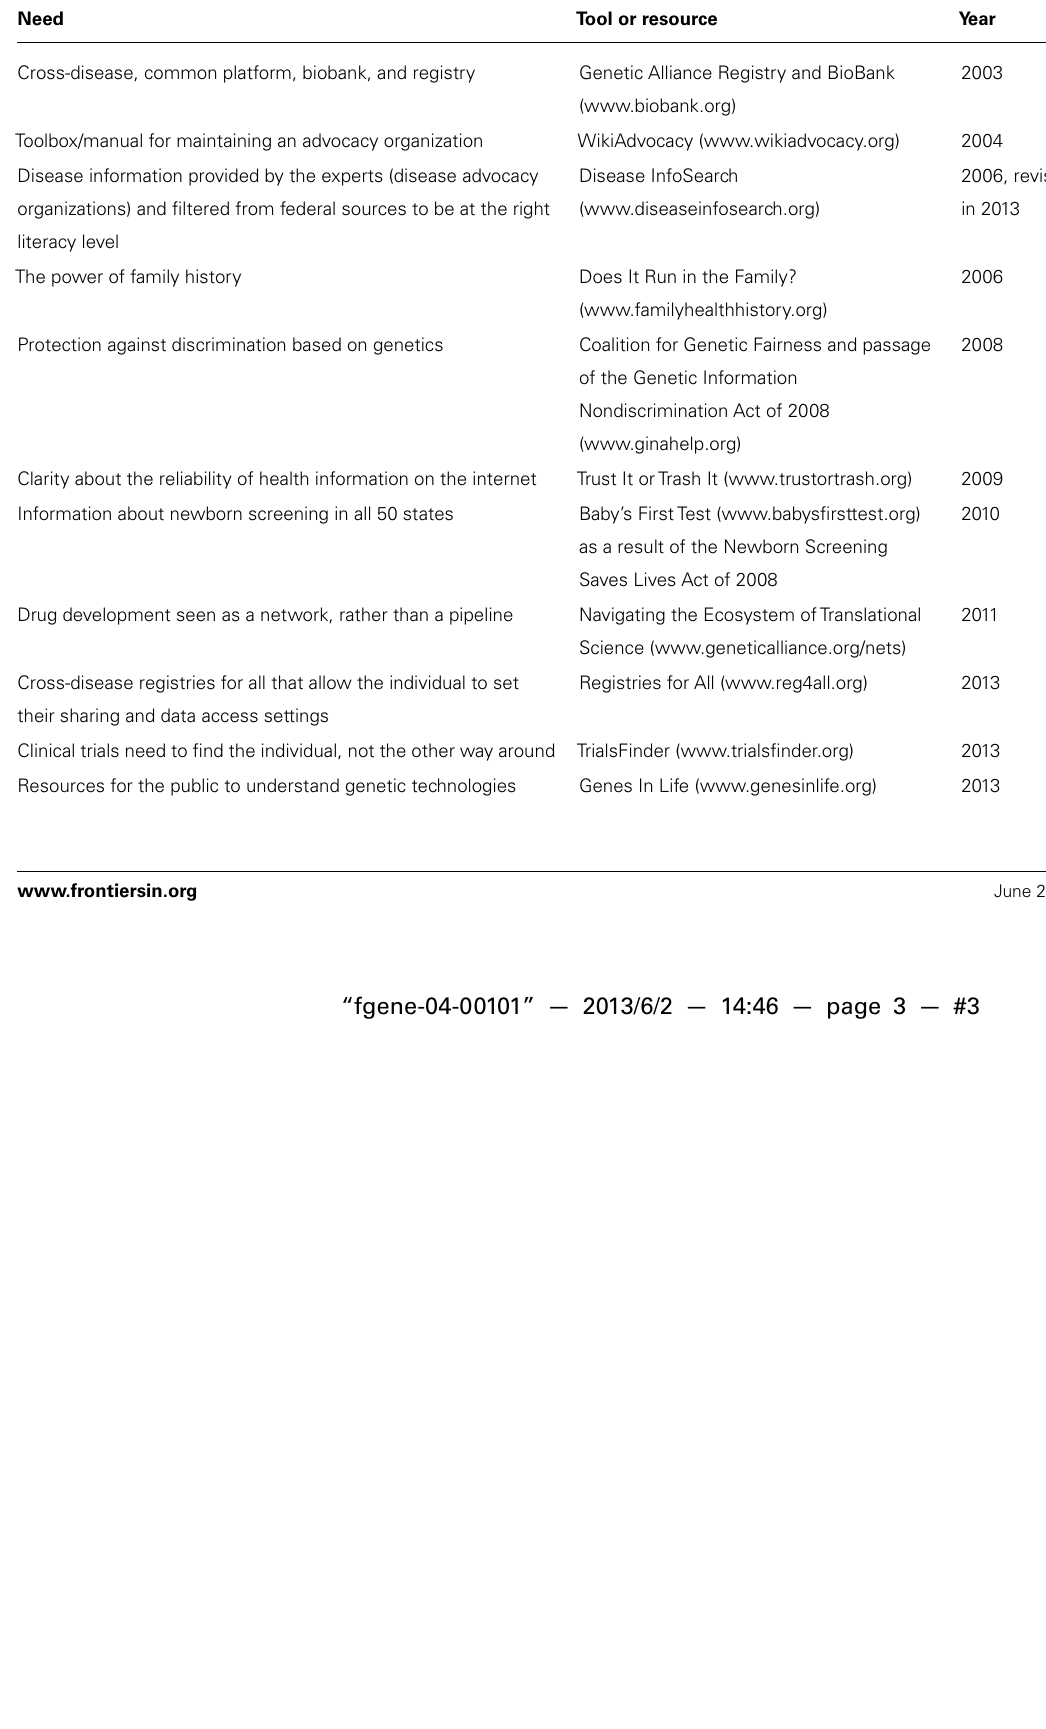
Table 1 | Resources and tools to accelerate research and services. Need Tool or resource Year Cross-disease, common platform, biobank, and registry Genetic Alliance Registry and